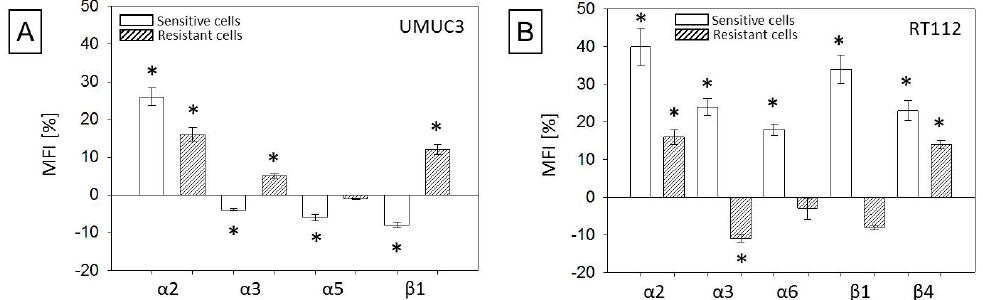
Figure 8. Surface integrin modification by temsirolimus. ( A ) UMUC3par and UMUC3res and ( B ) RT112par and RT112res. Corresponding controls were set to 0. Difference is presented as MFI [%]. Bars indicate standard deviation (SD), * indicates significant difference to corresponding control, p ≤ 0.05. n = 3.